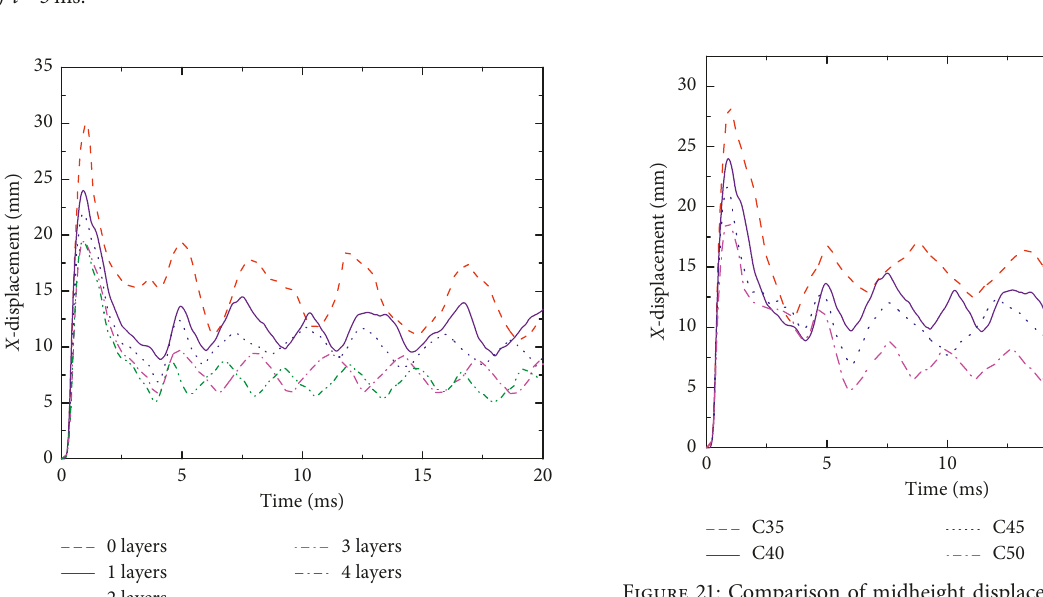
Figure 19: Effective stress contours of a steel tube at different time periods (front view): (a) t � 0.3ms, (b) t � 1ms, (c) t � 2ms, and (d) t � 3ms.